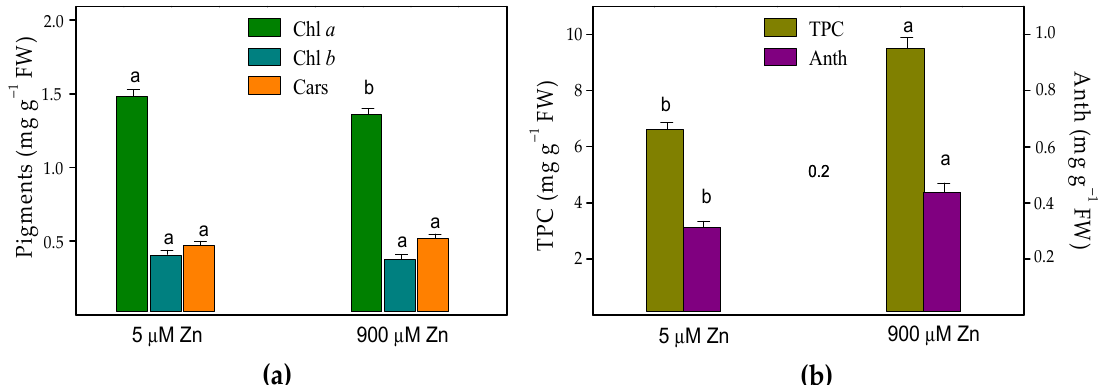
Figure 5. Effects of 5 µM (control) or 900 µM (excess) Zn exposure for 8 days on ( a ) the contents of the pigments: chlorophylls (Chl a and Chl b ) and carotenoids (Cars) and ( b ) total phenolic contents (TPC; expressed as mg of a gallic acid equivalent per g FW) and anthocyanins (Anth; expressed as mg of a cyanidin-3-glucoside equivalent per g FW) in the leaves of Salvia sclarea . Different letters indicate significant differences between the mean values (±SE) for the same parameters ( p < 0.05).